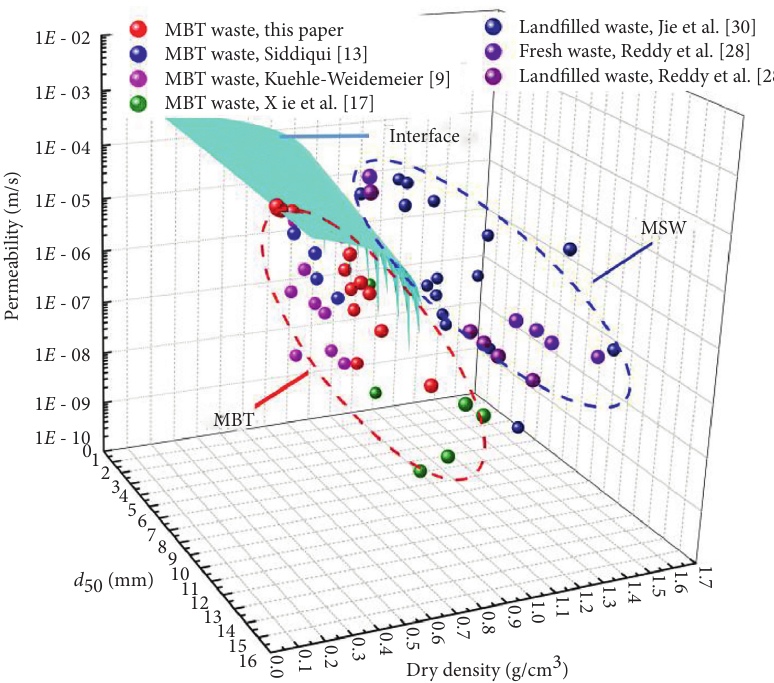
Figure 11: Comparison of permeability of MBT waste and MSW.